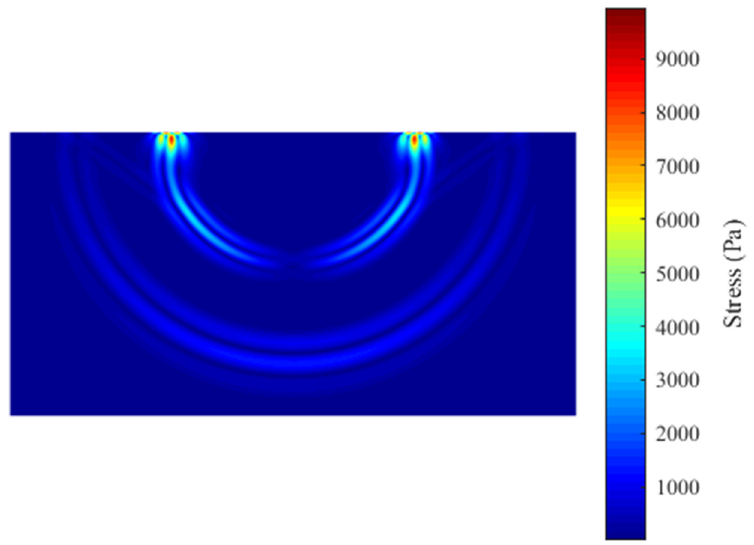
Figure 6. The calculated von Mises stress distributions from the present EFEM at observation time t = 0.5 s.